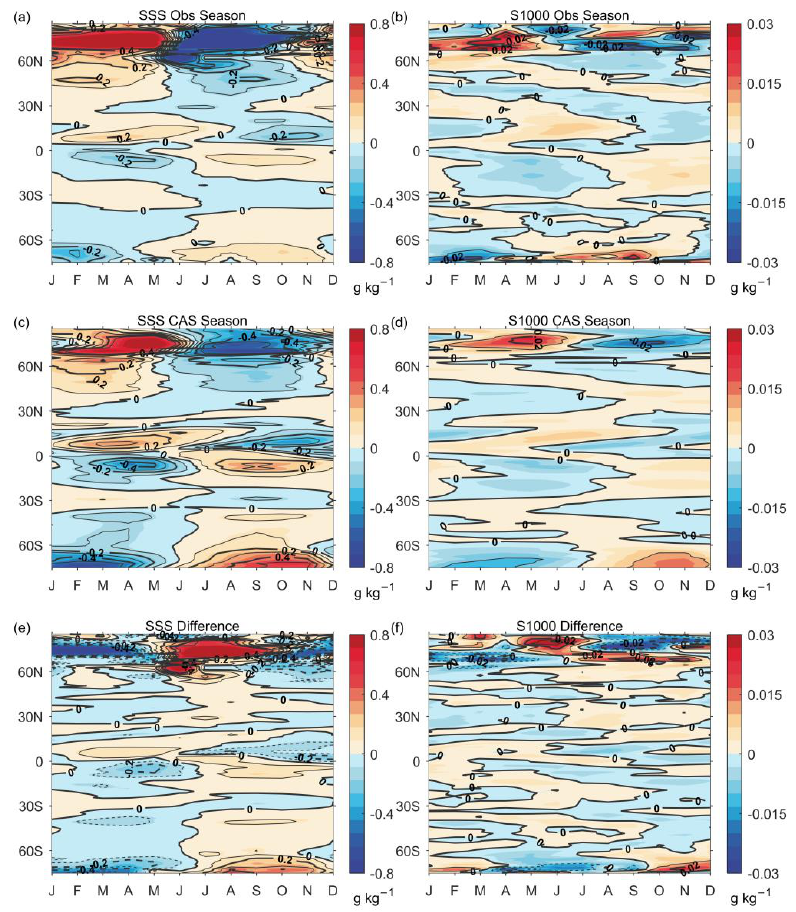
Figure 3. Global zonal mean of the seasonal variation of the ( a ) sea surface salinity (SSS) and ( b ) 0–1000 m averaged salinity (S1000) for the observational mean, ( c , d ) for CAS-ESM2-0 model. The differences between the model and observational mean are shown in ( e , f ), respectively. The monthly anomalies are obtained from the 12-month climatological means, which has removed the annual mean during